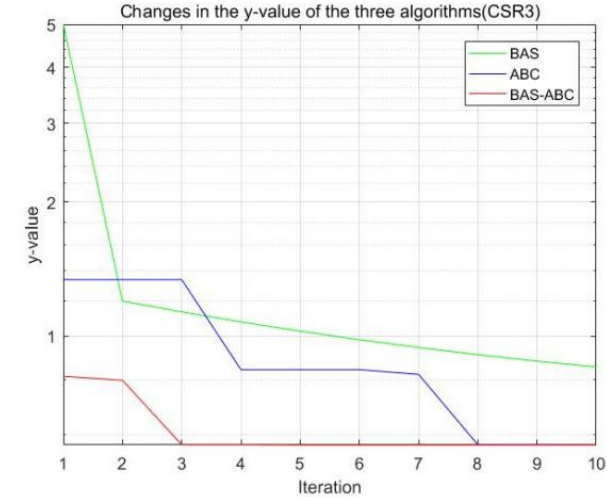
Figure 12. Changes in the y value of the three algorithms (CSR3).